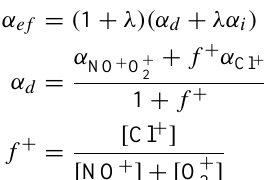
Fig. 8. Electron density profiles on 17 January 2005 at 13:30UT and at 14:00UT. Upper panel: Model N e -profiles at 13:30UT ( χ =95.0 ◦ ) are based on O-profiles 4 and 3; N e -profile measured with EISCAT radar at 13:30UT ( χ =95.0 ◦ ) is shown by red line. Lower panel: Model N e -profiles at 14:00UT ( χ =98.3 ◦ ) are based on O-profiles 4 and 3; N e -profile measured with EISCAT radar at 14:00UT ( χ =98.3 ◦ ) is shown by red